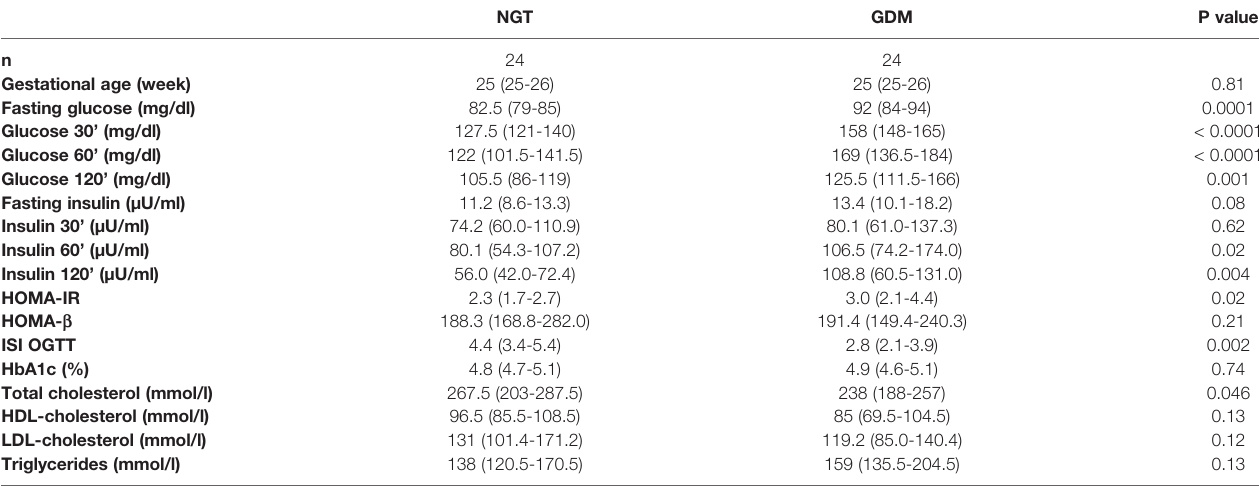
TABLE 2 | Clinical characteristics of groups studied in the 2 nd trimester.